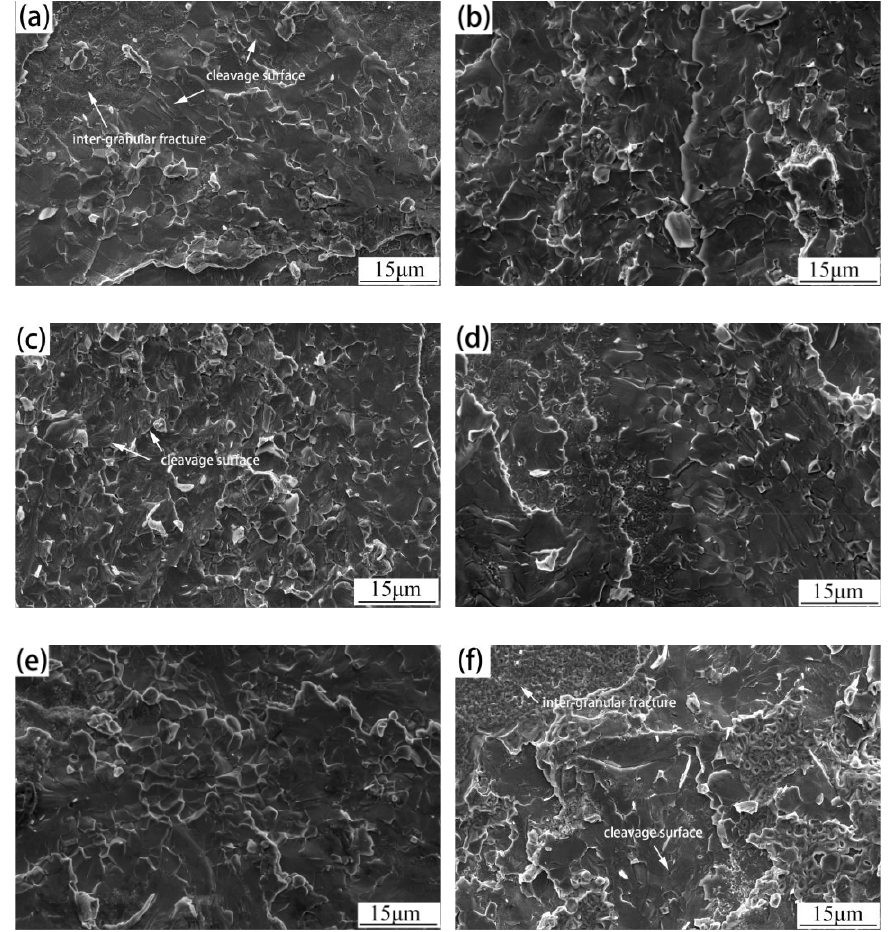
Figure 16. Fractography at the Cu side of 3003 Al/Cu joints brazed by: ( a ) Zn-2Al; ( b ) Zn-5Al; ( c ) Zn-12Al; ( d ) Zn-15Al; ( e ) Zn-20Al; and ( f ) Zn-25Al.